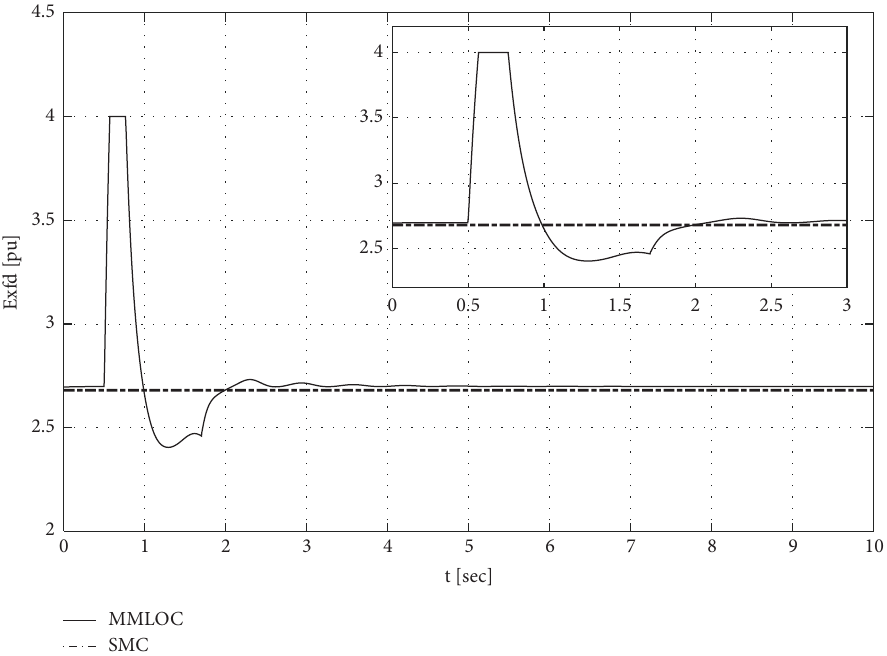
Figure 8: Exciter voltage of the generator with MMLOC and